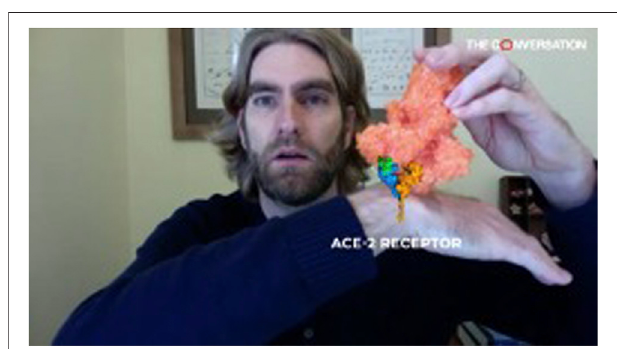
FIGURE 11 | Augmented reality representation of Covid-19 (Ahlgren,